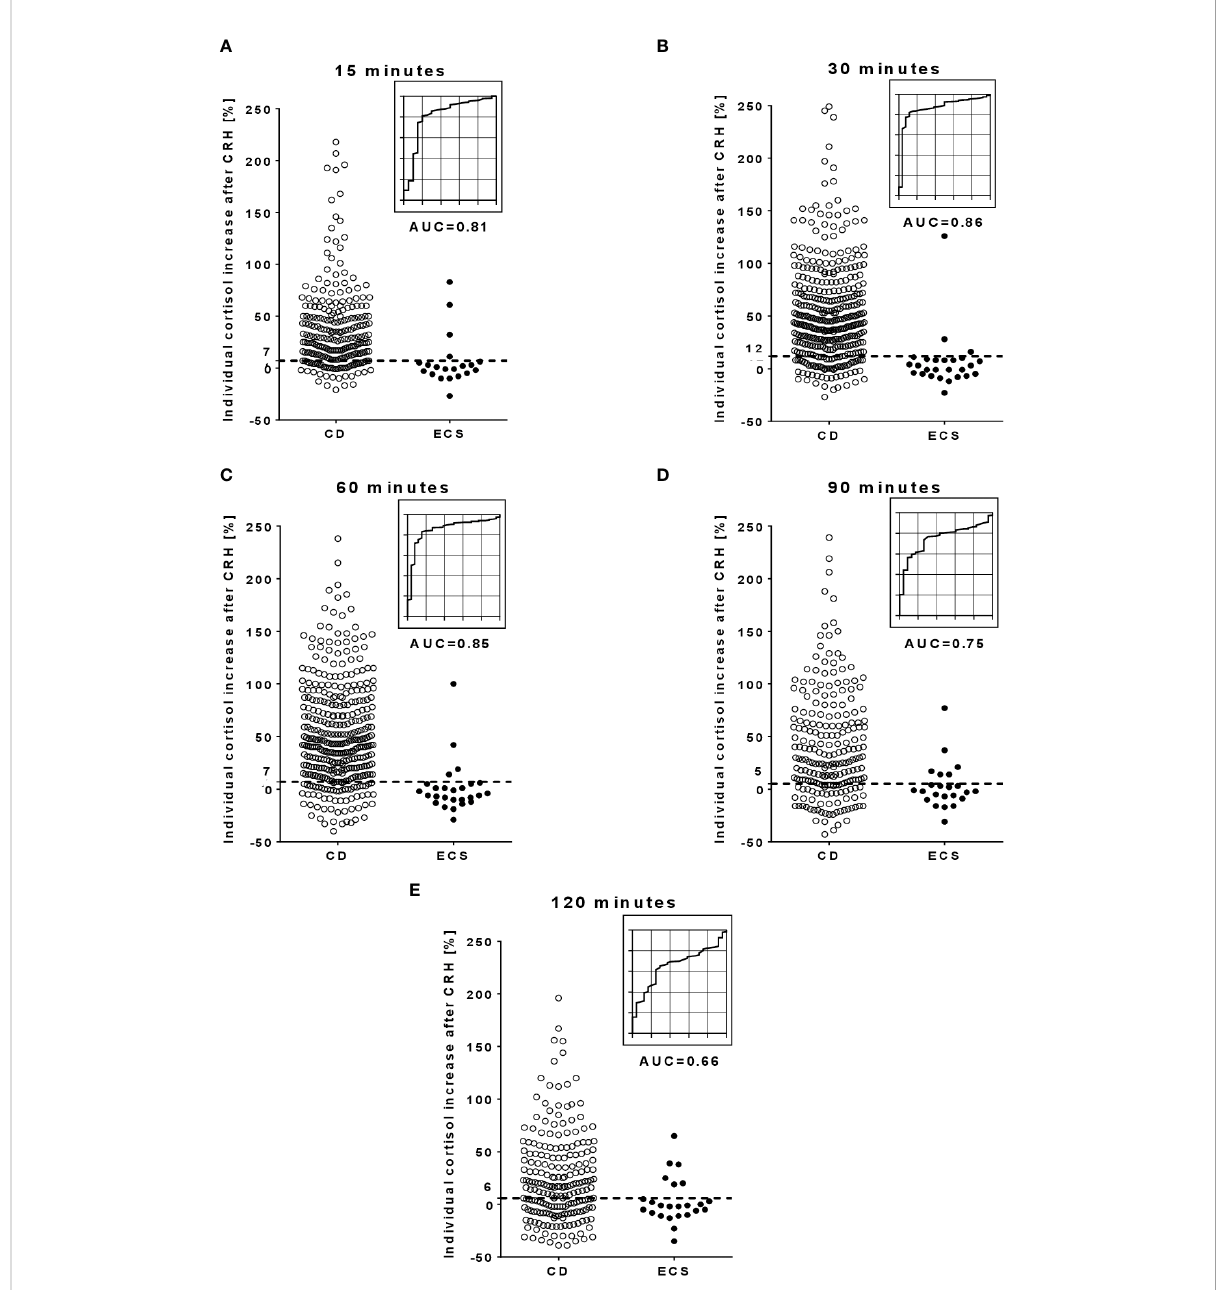
FIGURE 3 Individual %-increase of cortisol after CRH and corresponding ROC curves at different time points during the CRH stimulation test. ( A , at 15 minutes; B , at 30 minutes; C , at 60 minutes; D , at 90 minutes; E , at 120 minutes). The dotted lines in the scatter plots illustrate the optimal cut- off for the post-CRH %-increase of cortisol. Few outlier results are not reported in the scatter plots: 1 CD patients at 15 minutes, 7 CD patients at 30 minutes, 9 CD patients at 60 minutes, 4 CD patients at 90 minutes, and 2 CD patients at 120 minutes. AUC, area under the curve; CD, Cushing ’ s disease; CRH, corticotropin-releasing hormone; ECS, ectopic Cushing ’ s syndrome; ROC, receiver operator